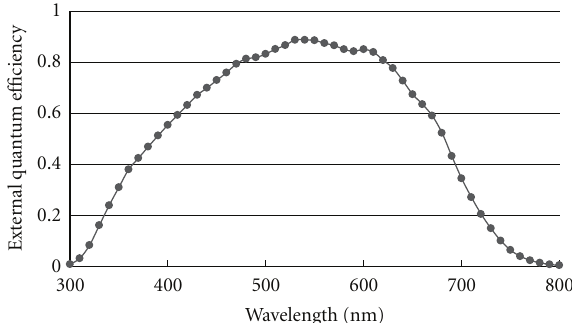
Figure 6: Quantum e ffi ciency curve with wavelength in the range of 300–800